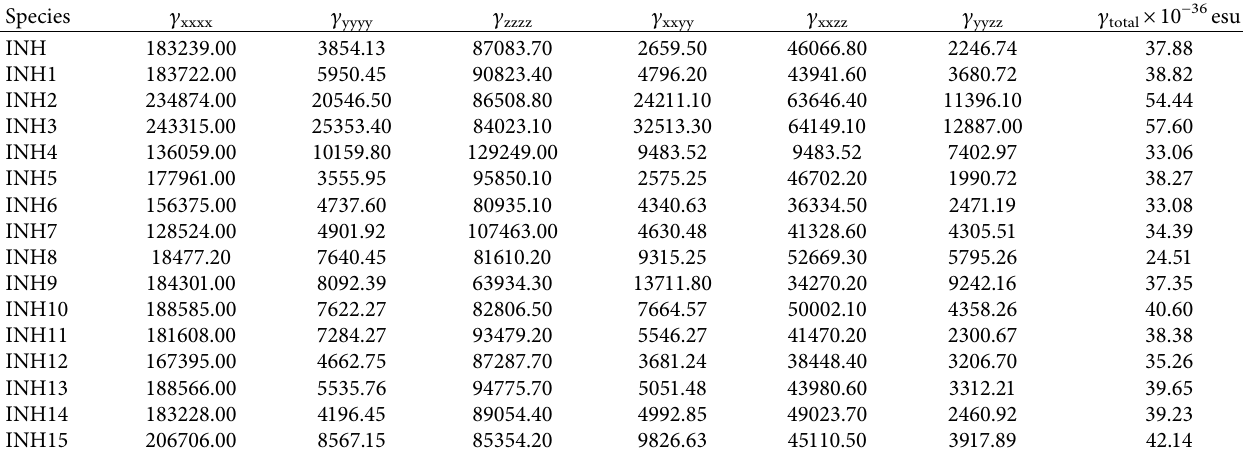
Table 8: Te static second hyperpolarizability ( c theory in the gaseous